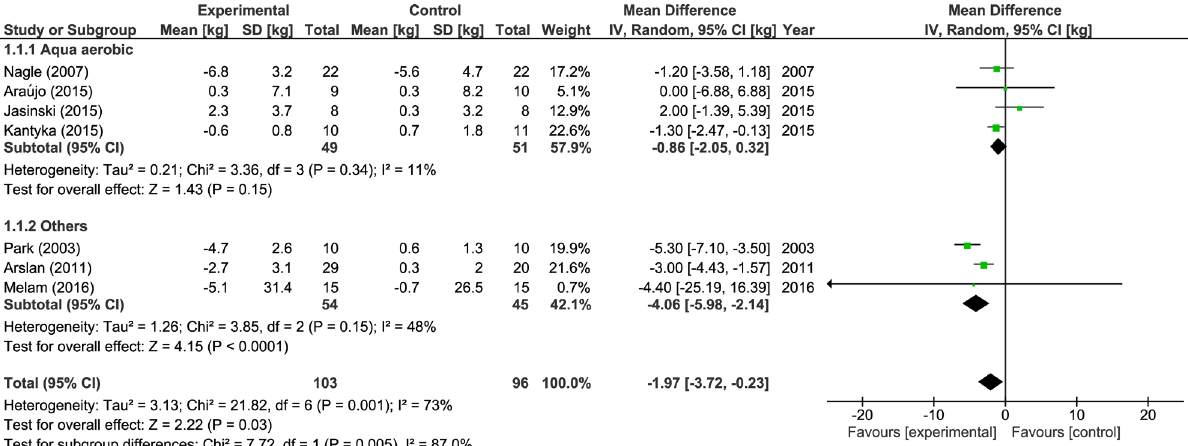
Figure 2. Assessment of the effect of various types of aerobics on body